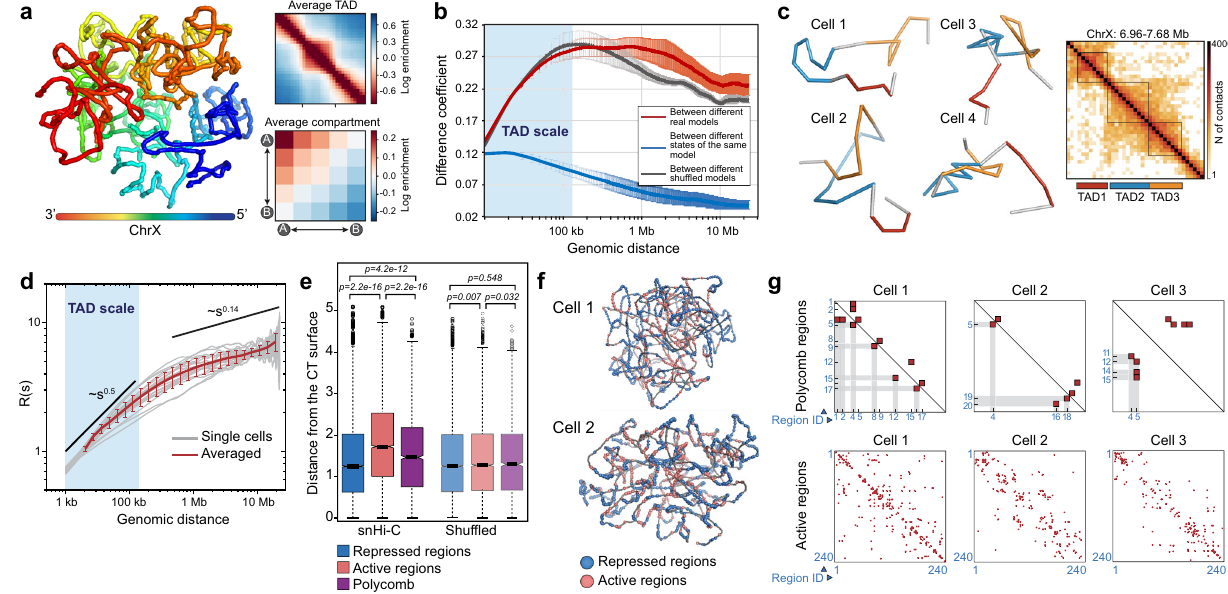
Fig. 5 3D folding of the haploid X chromosome. a Left panel: 3D structure of the haploid X chromosome from an individual nucleus derived from snHi-C data by the DPD polymer simulations. Right panel: averaging of contacts in the 3D model over TAD positions in the corresponding snHi-C data (top) and compartment (bottom) positions annotated in the bulk BG3 in situ Hi-C data. Source data are provided as a Source data fi le. b Coef fi cient of difference over a broad range of genomic distances. The central curves represent average values. Error bars show standard deviation (SD) for 20 independent model realizations, n = 2242 distinct ranges of genomic distances used for the curve construction. c Single-nucleus 3D structures of a genomic region covered by three TADs (left). Right, bulk BG3 in situ Hi-C map of this region. TAD positions are shown by colored rectangles below the map and by black squares on the map. d Dependence of the Euclidean spatial inter-particle distance R (see “ Methods ” ) on the genomic distance s between these particles along the chromatin fi ber. Black lines show the slopes characteristic for the random walk behavior ( s 0.5 ) and the crumpled globule build-up from Gaussian blobs ( s 0.14 ). Error bars show standard deviation (SD) for 20 independent model realizations, n = 20. e Spatial distance from the surface of a chromosome territory (CT) to transcriptionally active ( n = 8966) and inactive ( n = 17,103; according to RNA-seq from ref. 24 ) regions, and Polycomb-bound domains ( n = 2160; according to the 9-state chromatin type annotation 54 ). Boxplots show data aggregated from all individual models analyzed. Boxplots represent the median, interquartile range, maximum and minimum. P -values are calculated using the Mann – Whitney two-sided test. f Examples of simulated ChrX 3D structures demonstrating the preferential location of transcriptionally inactive regions (blue particles) at the surface of the CT. g Heatmap showing cell- to-cell variability in interactions detected between Polycomb domains (upper panels) or between transcriptionally active regions (bottom panels) in individual cells. Red rectangles denote detected interactions. The total number of Polycomb and active regions identi fi ed in the X chromosome are 20 and 240, respectively (see “ Methods ” ). Only interacting domains are numbered for Polycomb domains; interacting active regions are not numbered due to their